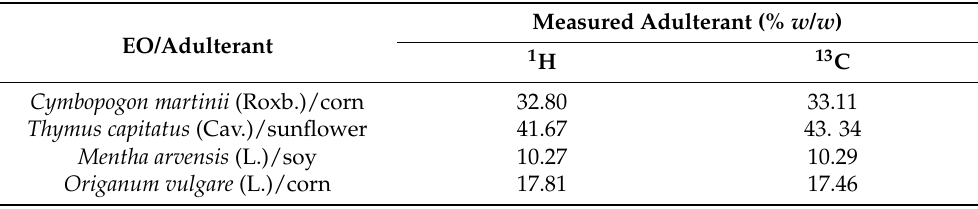
Table 5. Quantitative results of vegetable oils expressed as adulterant percentage ( w/w ) found in commercial samples of